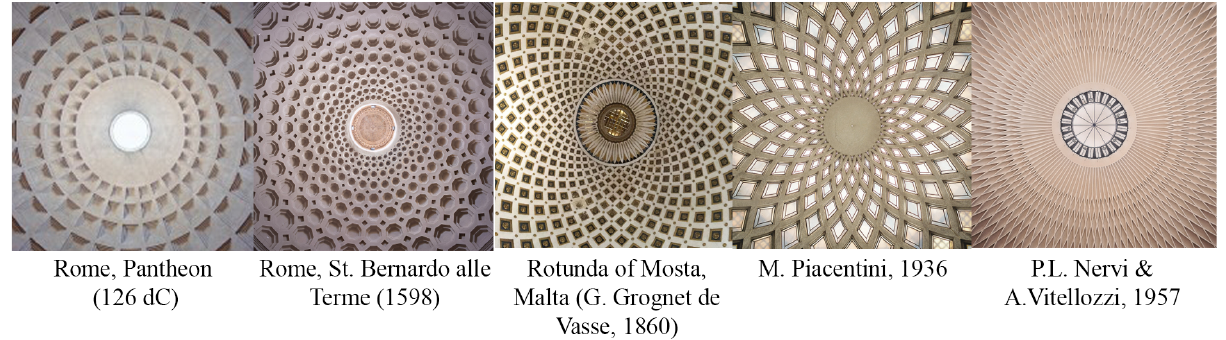
Figure 6: Comparison between different rib patterns in domes from antiquity to present